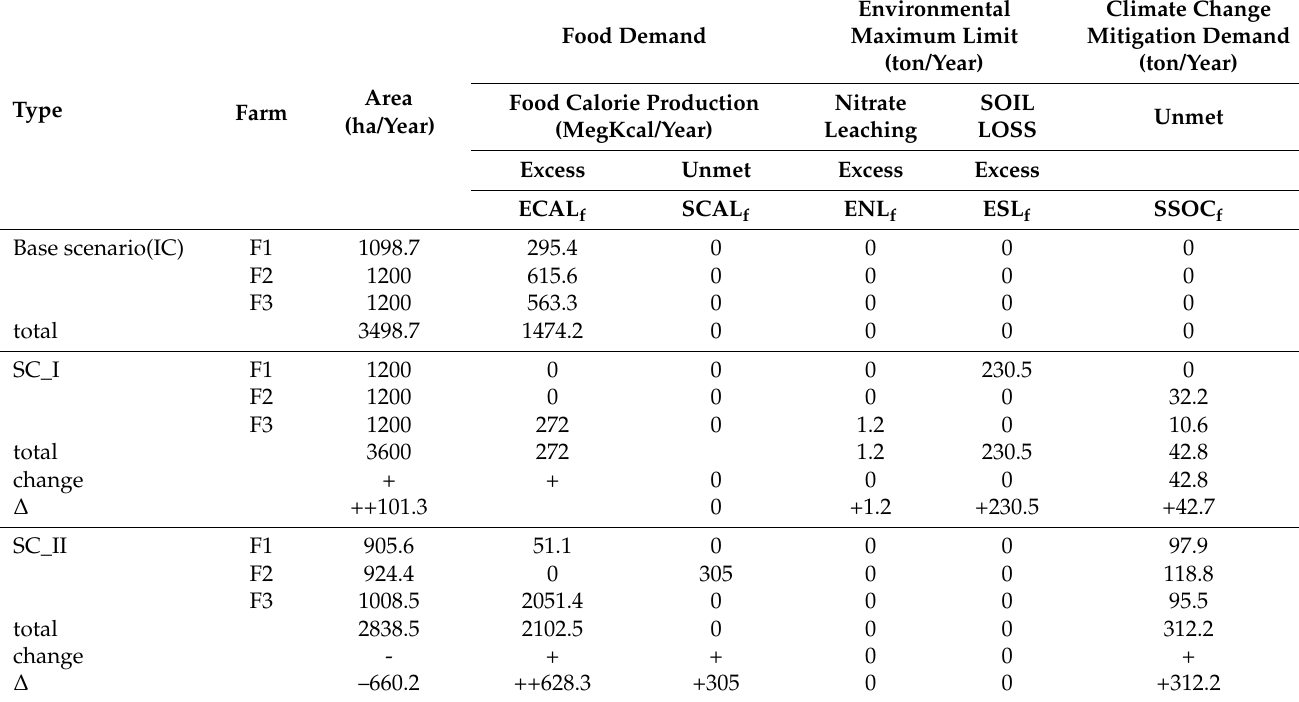
Figure 34. Comparison of irrigation water allocation between scenario II and the initial base scenario conditions (Mm 3 /week). Table 13. Comparison of optimized land allocation and attributes under different model scenario conditions.